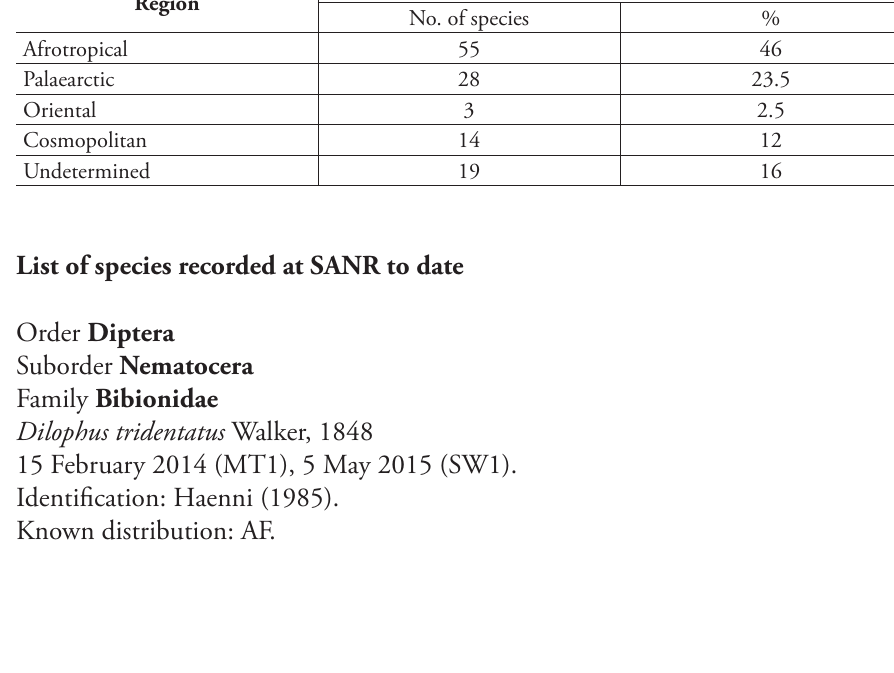
Table 2. Zoogeographic affinities of fly species of Jabal Shada al-A’la Nature Reserve (SANR). Affinities Region No. of species % Afrotropical 55 Palaearctic